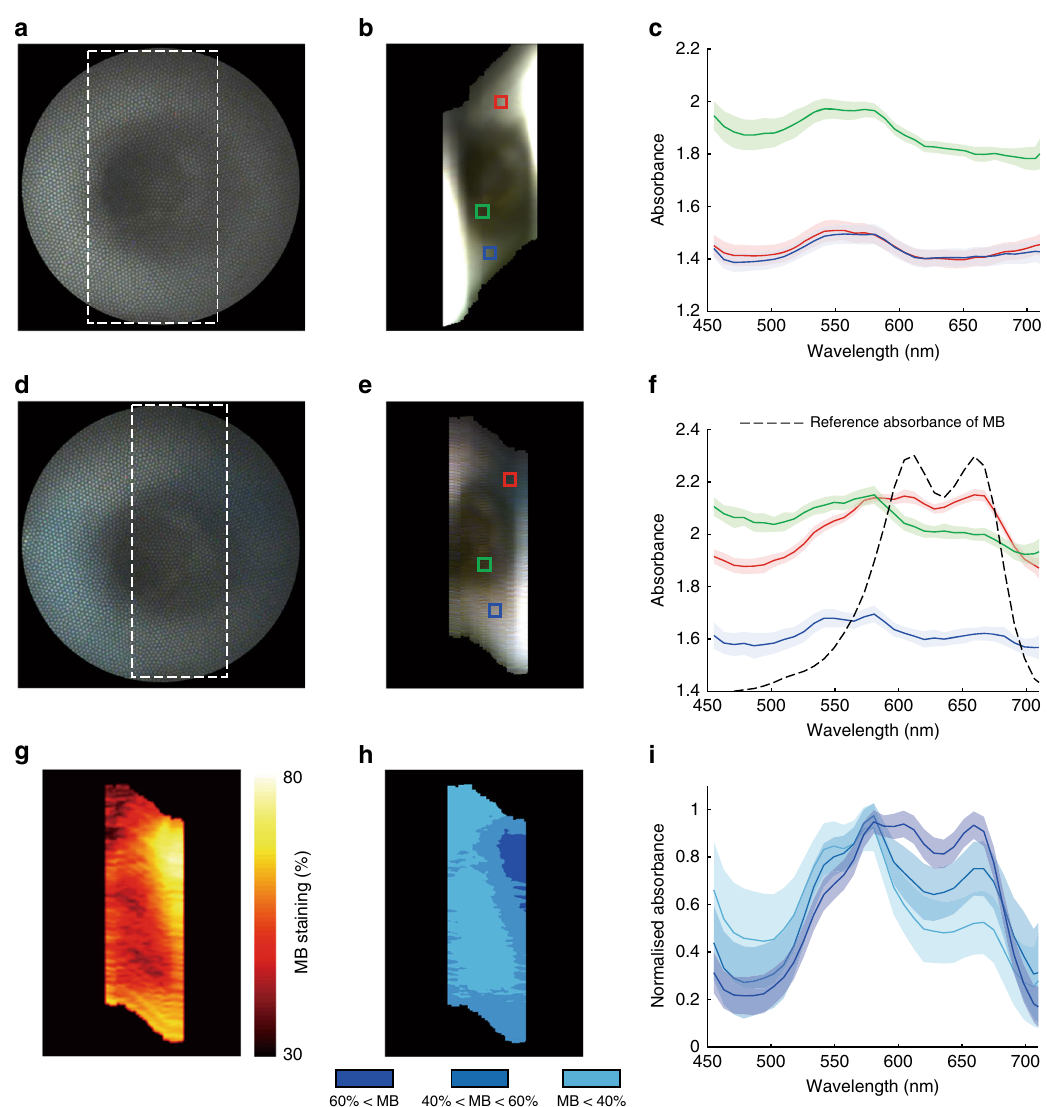
Fig. 8 Hyperspectral imaging (HSI) of an intact ex vivo pig oesophagus. a Wide- fi eld image, b synthesised RGB image and c absorbance spectra of the pig oesophagus. d – f Images and spectra from the same fi eld of view after methylene blue (MB) staining. Dashed squares in a , d indicate the acquisition area of HSI. Colours in c , f correspond to the coloured squares drawn in b , e , respectively. g Concentration of MB staining estimated by linear spectral unmixing using the average absorption spectrum of normal pig oesophageal tissue and the experimentally measured absorption spectrum of MB as endmembers. h Segmentation of estimated MB concentration according to unmixing values. i Quanti fi cation of normalised absorption spectral pro fi le of each segment in h . Solid lines and shaded areas in c , f , i indicate mean value and standard deviation of the absorbance pro fi le, respectively. All hyperspectral images were measured using the internal illumination